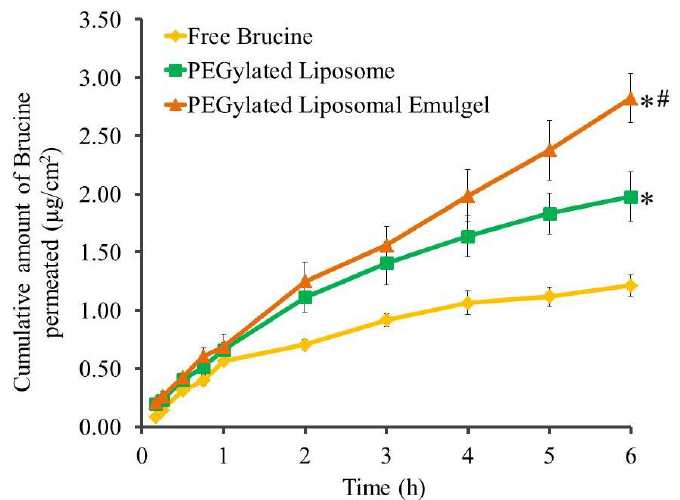
Table 4. Skin permeation parameters of different developed formulations.